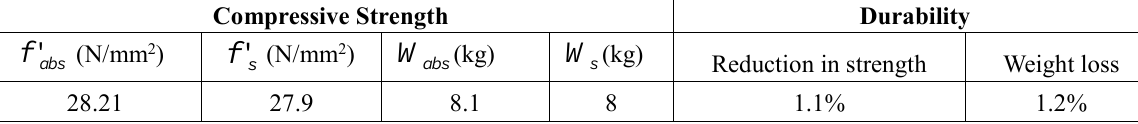
The Reduction in Strength and Weight Loss for the Response Parameters. Compressive Strength